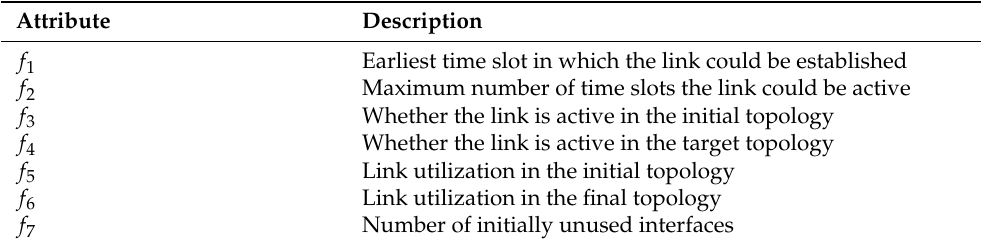
Table 2. Possible link